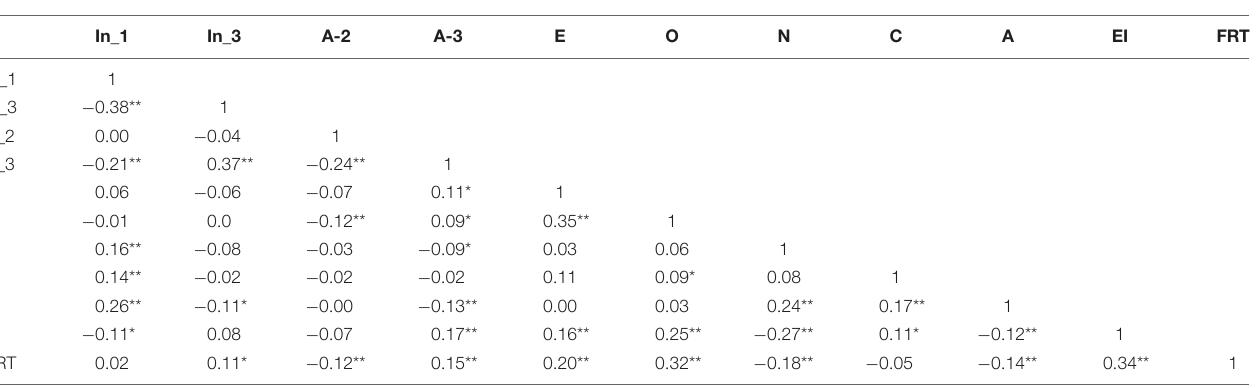
TABLE 2 | Correlation analysis.